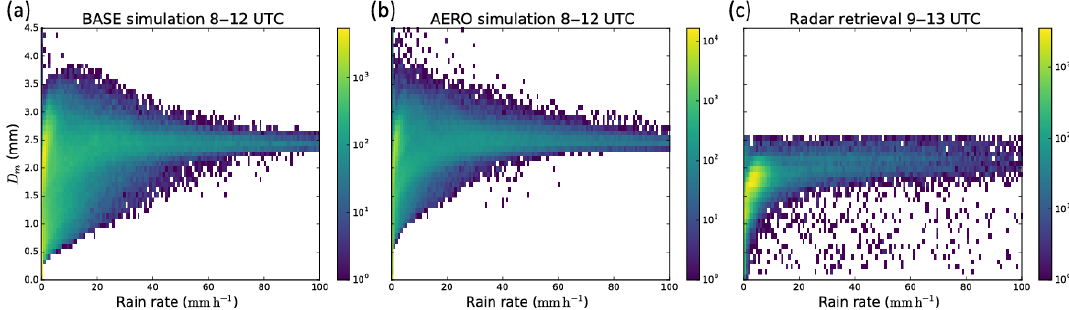
Figure 19. Joint histogram of mass-weighted mean diameter ( D m ) and collocated precipitation rate in BASE and AERO simulations and retrievals averaged over the red-bounded geographic region shown in Fig. 9 at 08:00–12:00UTC (simulated) or 09:00–13:00UTC